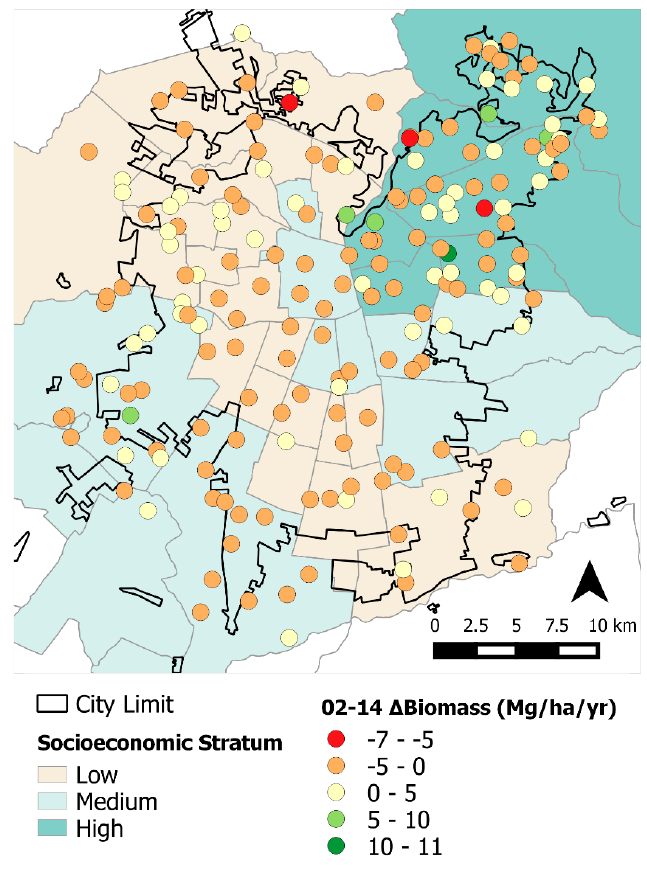
Figure 3. Plot-level urban tree biomass change in Santiago, Chile from 2002 to 2014 based on 192 re-measured plots.